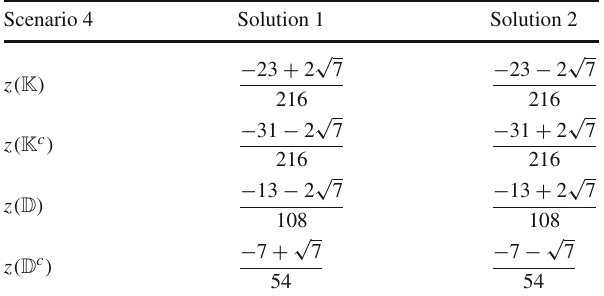
Table31 Valuesofthe U ( 1 ) (cid:2) chargesfortheexoticquarksinU μν SSM models using solution (30) with the hypercharges of Case 2 of Table 10 and irrational U ( 1 ) (cid:2) charges. The U ( 1 ) (cid:2) charges of the rest of the fields are given in Table 2 and Scenario 4 of Table 9. The minimal number of singlets under the SM gauge group consistent with these charges is